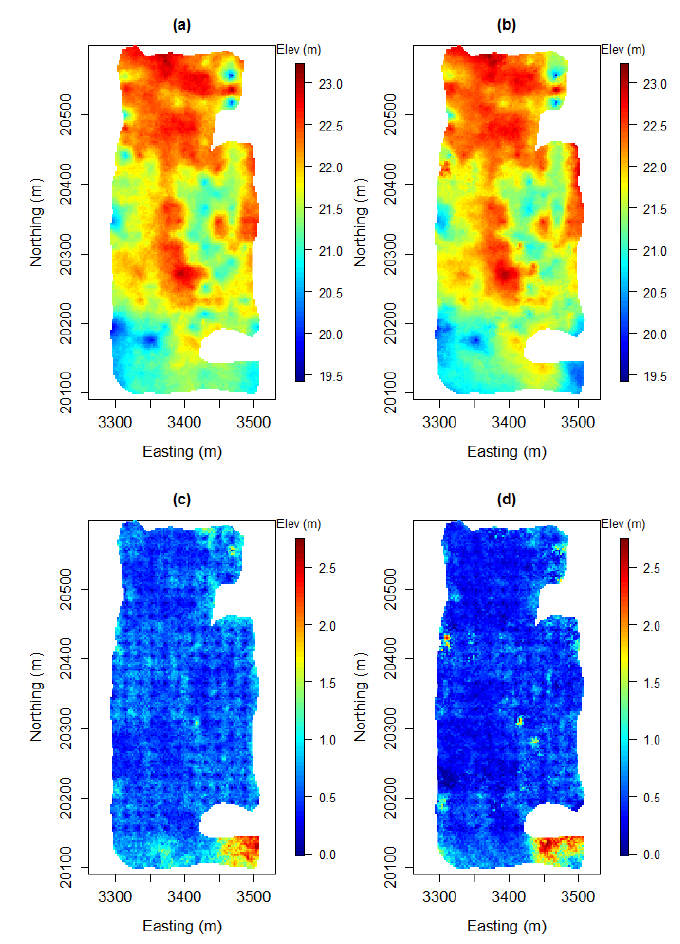
Figure 5. ( a ) Initial average of the realisations; ( b ) final average of the realisations. Interquartile range maps: ( c ) before the parameter optimisation and ( d ) after the parameter